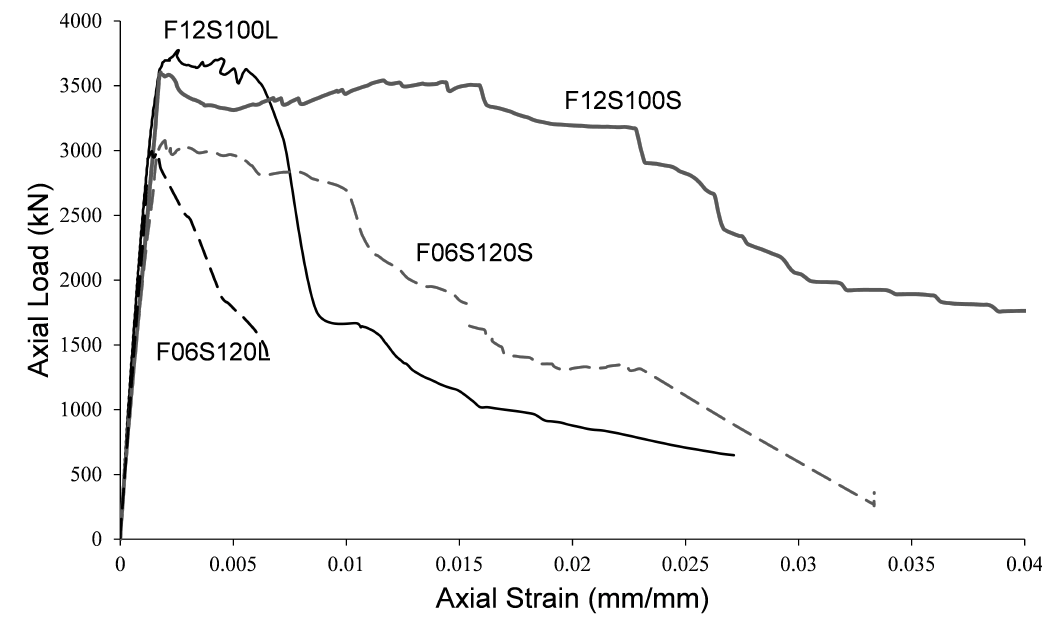
Figure 4. Appearance of specimens after testing.